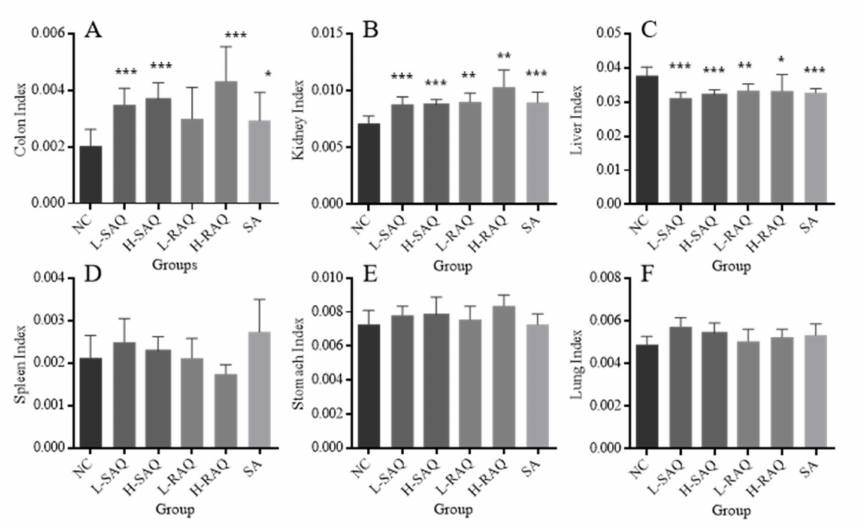
Figure 3. The organ index in normal control (NC) rats and diarrhea rats induced by a low dose of senna anthraquinones (L-SAQ), high dose of senna anthraquinones (H-SAQ), low dose of rhubarb anthraquinones (L-RAQ), high dose of rhubarb anthraquinones (H-RAQ) and sennoside A (SA) for over 6 days. * represents significant difference with the p < 0.05, ** represents significant difference with the p < 0.01, *** represents significant difference with the p < 0.001. ( A ) the colon index. ( B ) the kidney index. ( C ) the liver index. ( D ) the spleen index. ( E ) the stomach index. ( F ) the lung